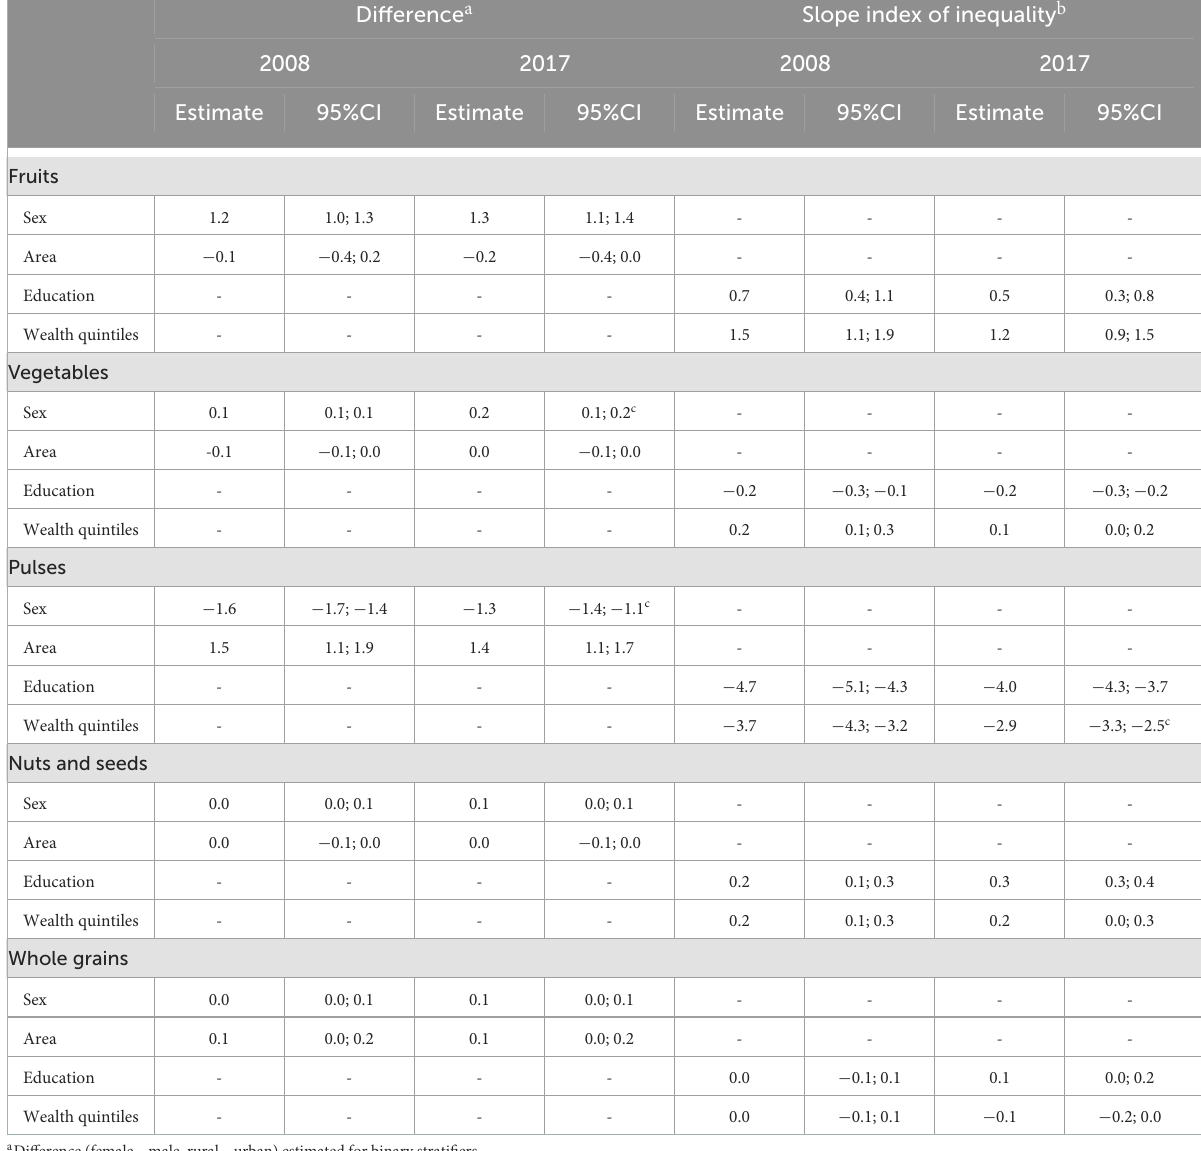
TABLE 3 Inequality measures for the set of plant-based natural or minimally processed foods subgroups in 2008 and